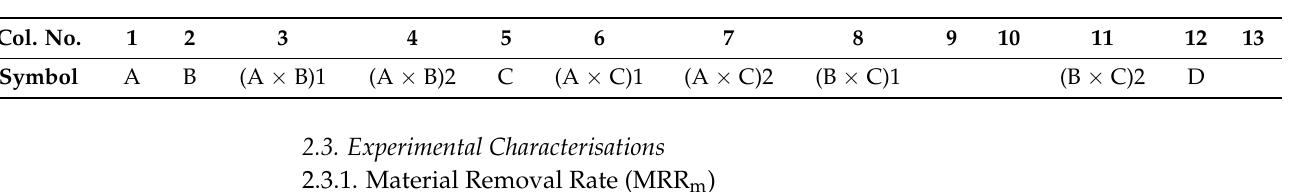
Table 2. Header design of the L 27 (3 13 ) orthogonal